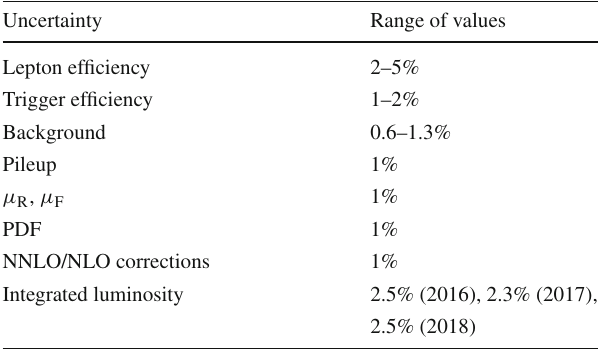
Table 1 The contributions of each source of systematic uncertainty in the cross section measurements. The integrated luminosity uncer- tainty, and the PDF and scale uncertainties, are considered separately. All other uncertainties are added in quadrature into a single system- atic uncertainty. Uncertainties that vary by decay channel are listed as ranges